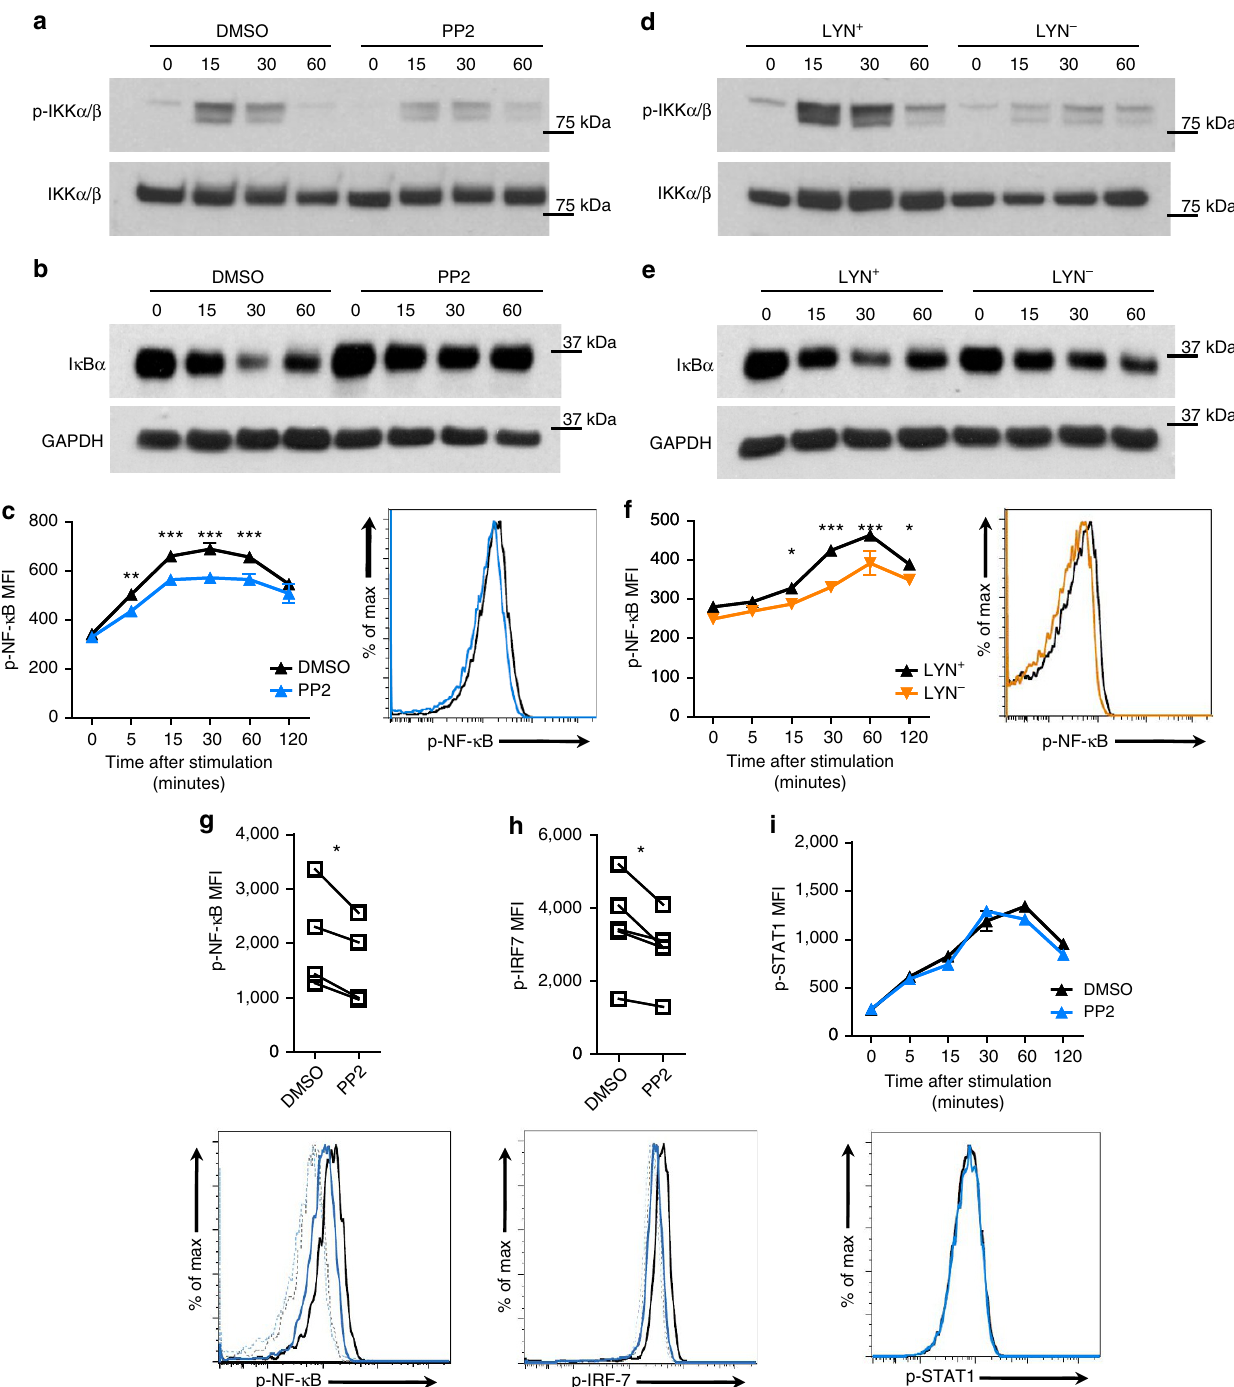
Figure 5 | SFKs are necessary for TLR signalling events in human pDCs. ( a – f ) WTor LYN (cid:2) ( d – f ) CAL-1 cells were pre-treated for 1h with PP2 (10 m M; a – c ; blue) or DMSO control ( a – c ; black) or left untreated ( d – f ; black: LYN þ , orange: LYN (cid:2) ), before stimulation with R848 for the indicated time periods (minutes). Level of p-IKK a / b and total IKK a / b ( a , d ) as well as I k B a ( b , e ) and GAPDH were assessed by immunoblot. p-NF- k B was determined by flow cytometry. The histogram depicts the 15min time point ( c , f ). ( g , h ) Human PBMCs were pre-treated as in c and stimulated for 15min with R848. p-NF- k B ( g ) and p-IRF-7 ( h ) were determined by flow cytometry in gated pDCs. Lines in graphs connect the same donor and histograms depict one representative donor; dotted lines, unstimulated; solid lines, R848 stimulation. ( i ) CAL-1 cells were pre-treated as in c before stimulation with recombinant IFN- b (1,000Uml (cid:2) 1 ) for the indicated time periods (minutes). p-STAT1 were determined by flow cytometry. Histogram depicts the 30min time point. Data are representative of two ( b , e , f , i ) or three ( a , c , d ) independent experiments and four ( g ) or five ( h ) donors processed separately. Graphs depict mean ± s.d. of replicates within one representative experiment ( a – f , i ) or individual donors ( g , h ). Two-way ANOVA ( c , f , i ) and two-ways Student’s t -test ( g , h ) were used for statistical analyses. * P o 0.05, ** P o 0.01, *** P o